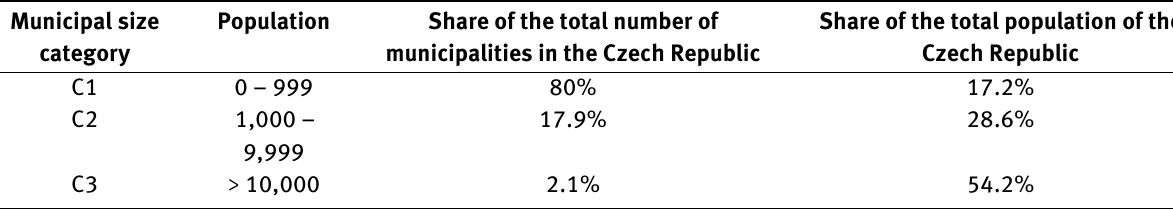
Table 2: Common number of small-scale public contracts for construction works Municipal Number of Contracts within CZK Contracts within CZK Contracts within CZK size category